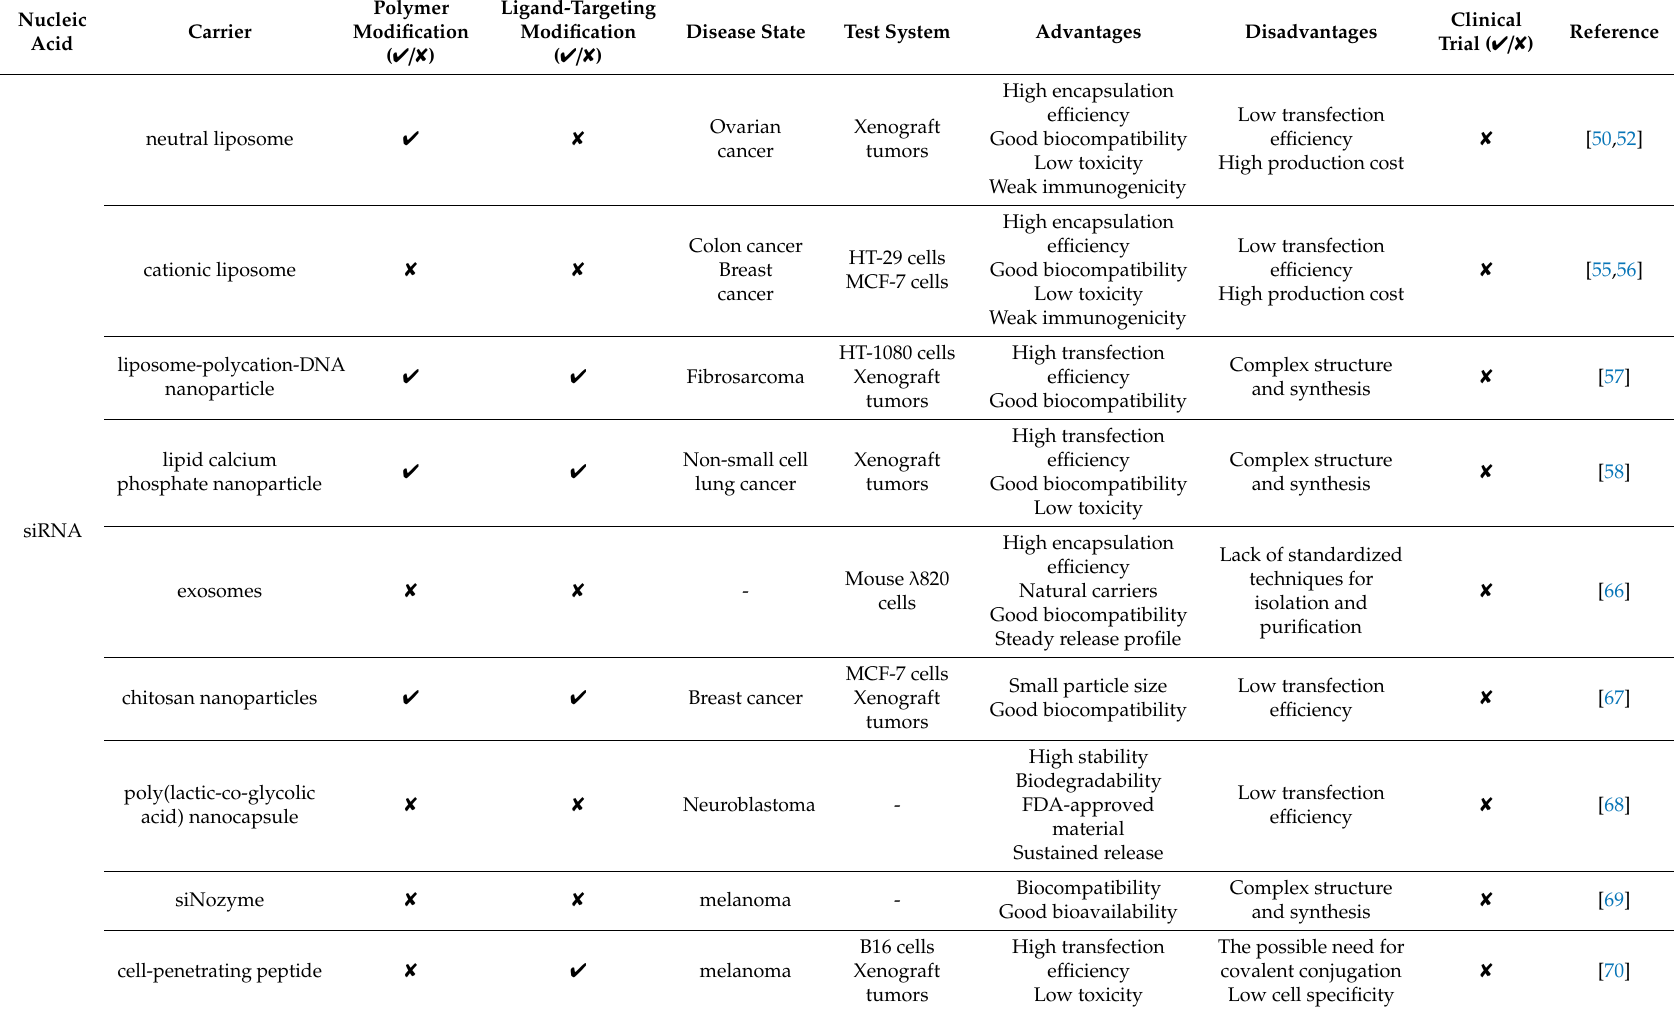
Table 1. Summary of anti- c-myc RNAi-based nanosystems developed to date. Symbols (cid:52) = present / yes; (cid:56) = absent / no. Nucleic